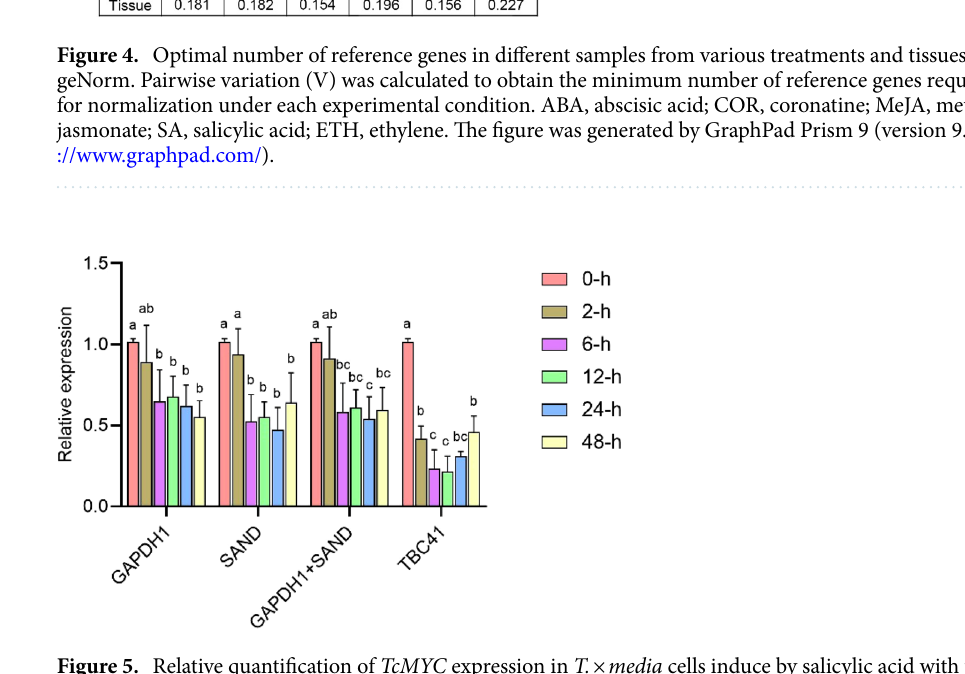
Figure 5. Relative quantification of TcMYC expression in T. × media cells induce by salicylic acid with two stable reference genes, GAPDH1 and SAND , separately or in combination, and the unstable reference genes TBC41 . The figure was generated by GraphPad Prism 9 (version 9.0.0; https ://www.graph